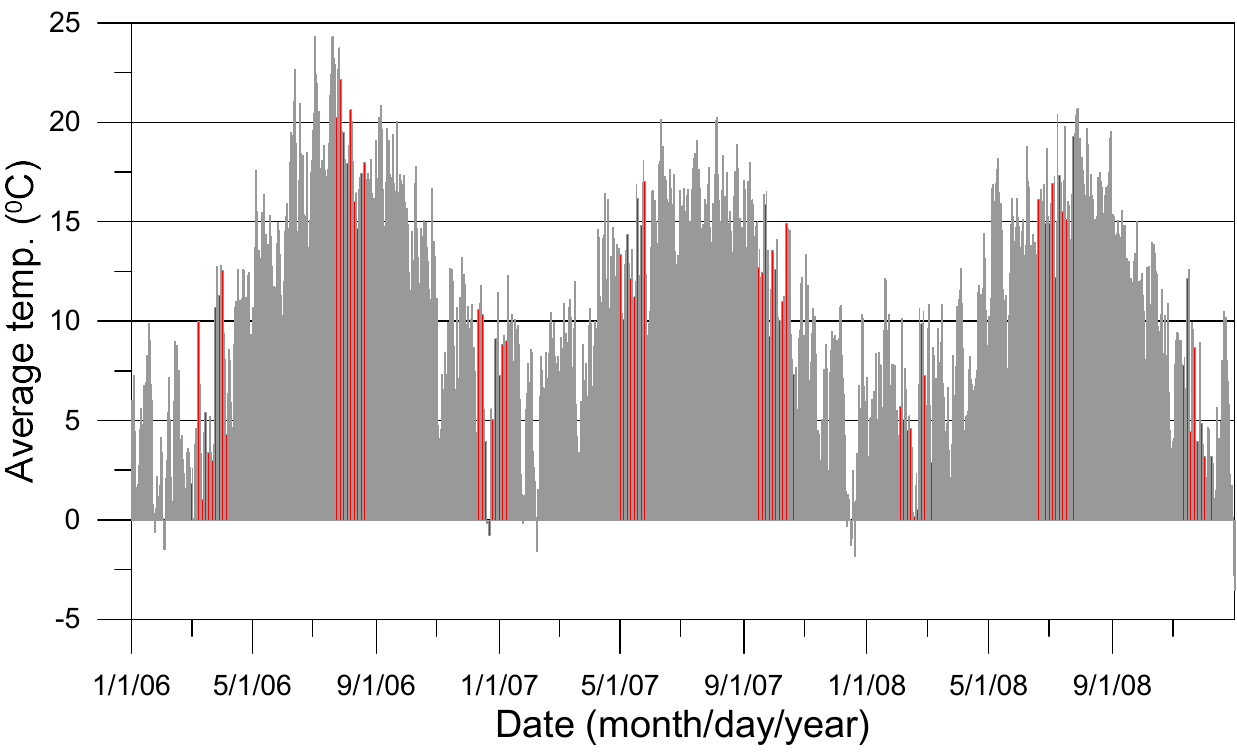
Figure A1. Average daily temperature at Newbury cutting.